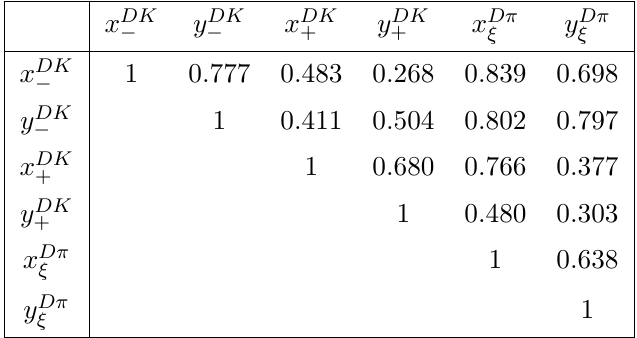
Table 6 . Experimental systematics correlation matrix obtained for the combined Belle and Belle II data